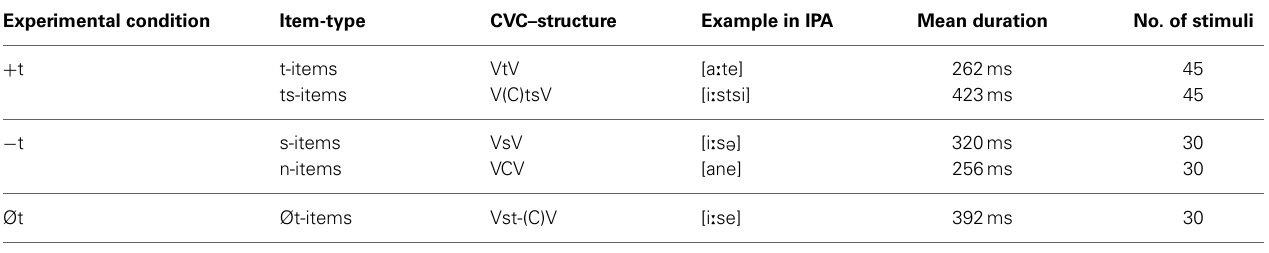
Table 1 | Stimuli in the experimental